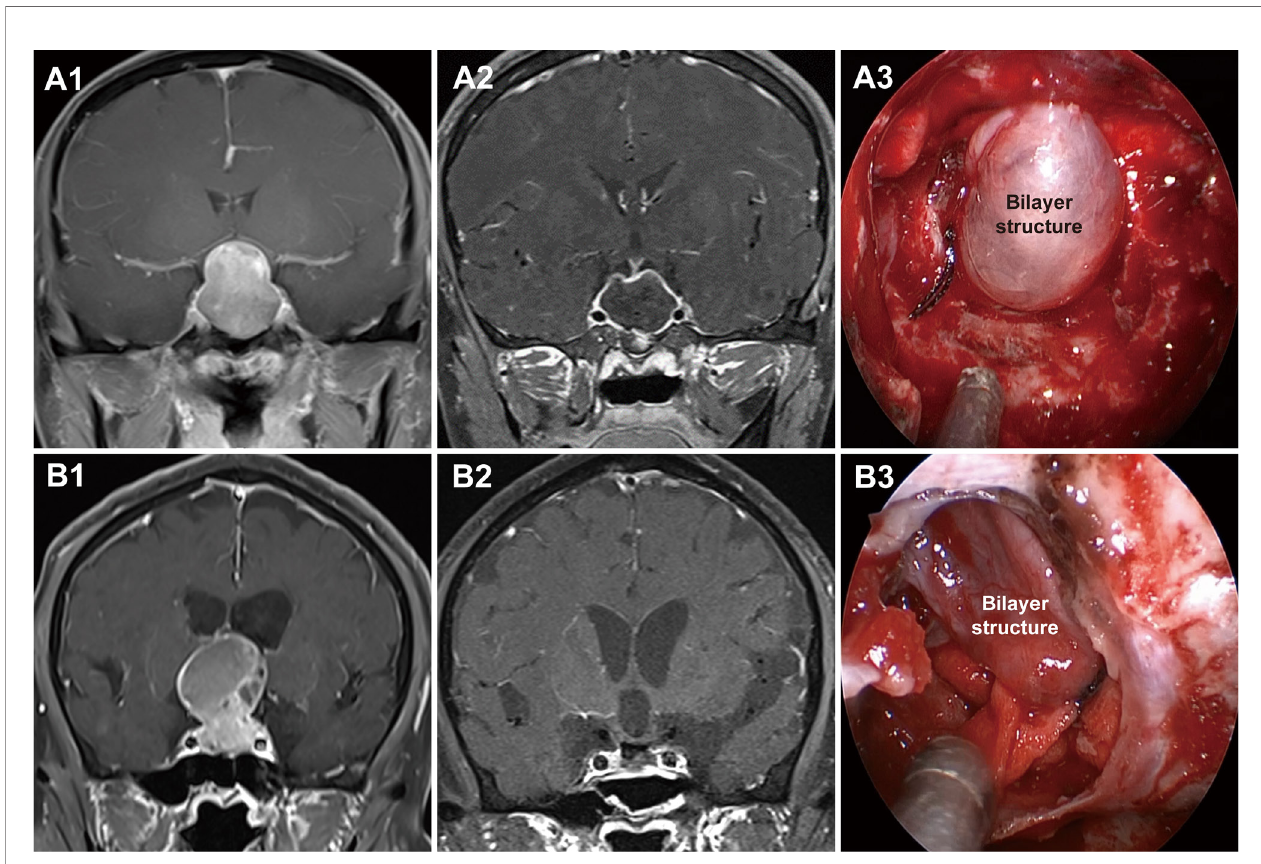
FIGURE 3 | Two cases with grade 1a pituitary adenomas (PAs). (A1, B1) Preoperative, coronal post-gadolinium magnetic resonance image (MRI) showing grade 1a tumor with a regular smooth shape and clear border. (A2, B2) Postoperative MRI showing gross total resection. (A3, B3) Endoscopic views showing an intact bilayer structure formed by the DS and DS-attached residual pituitary